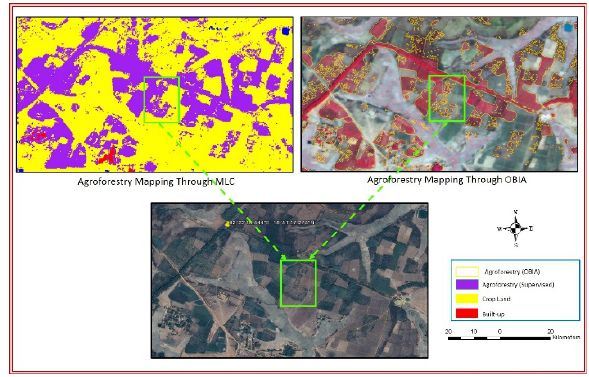
Figure 5. Agroforestry mapping through OBIA and